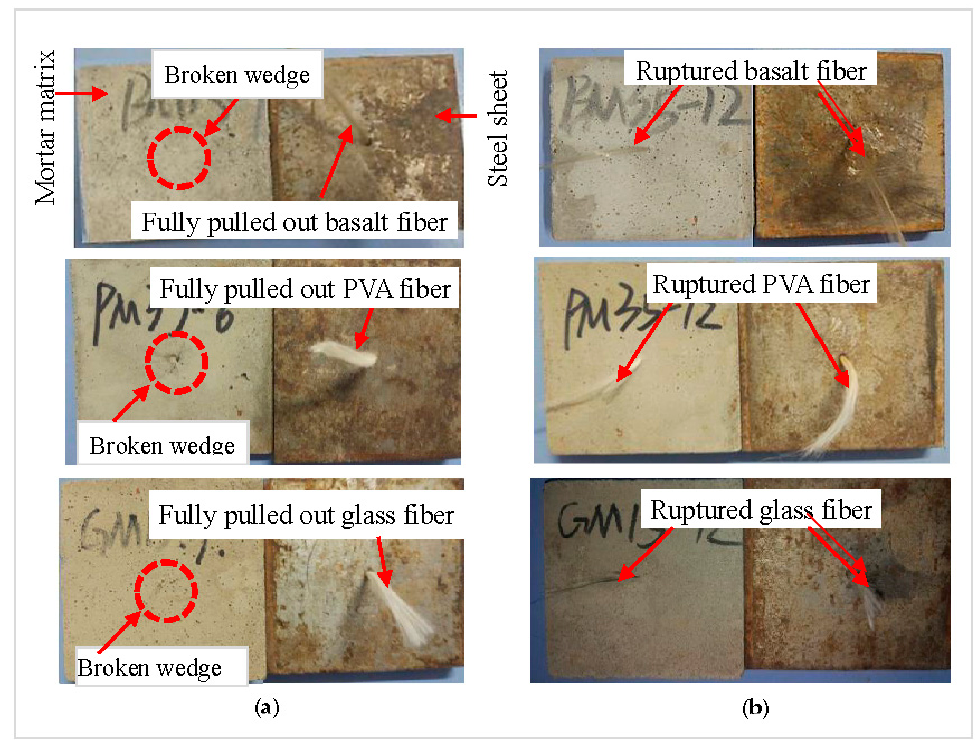
Figure 7. Typical failure modes of pull-out specimens: ( a ) fiber fully pulled out from mortar, and ( b ) fiber rupture.